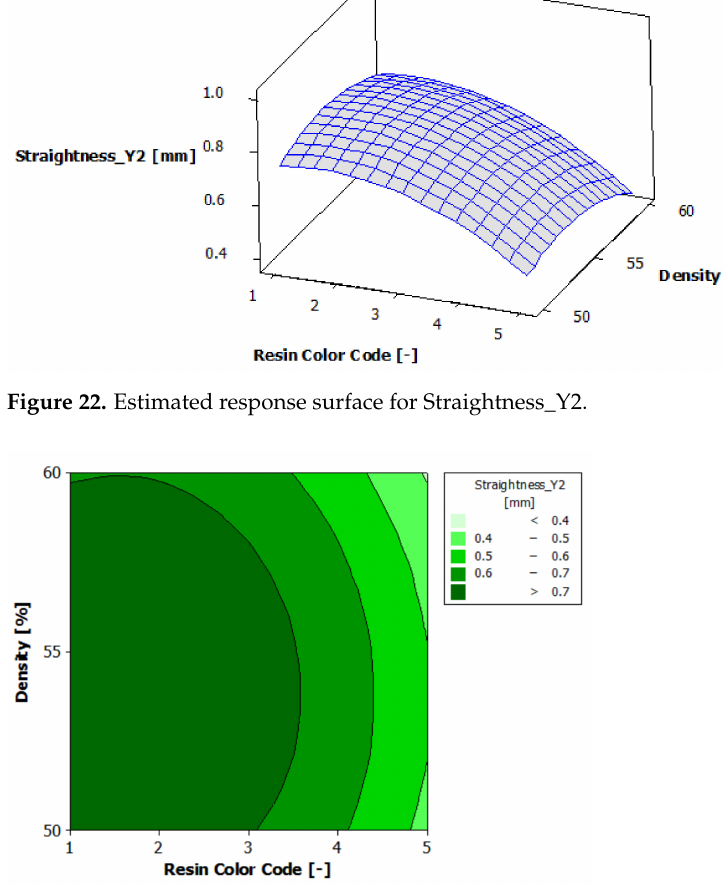
Figure 23. Contours of estimated response surface for